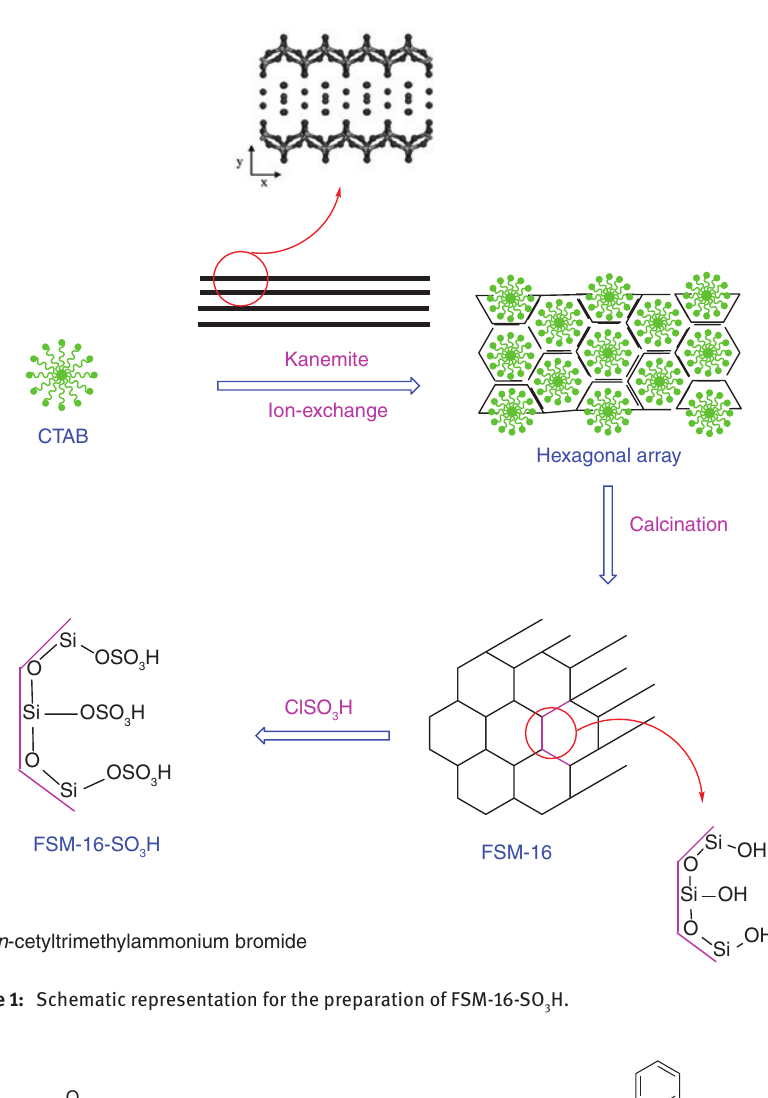
Scheme 1: Schematic representation for the preparation of FSM-16-SO